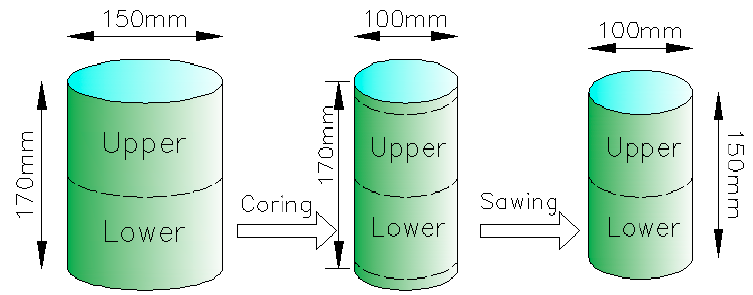
Figure 2. Sample Preparation procedure.